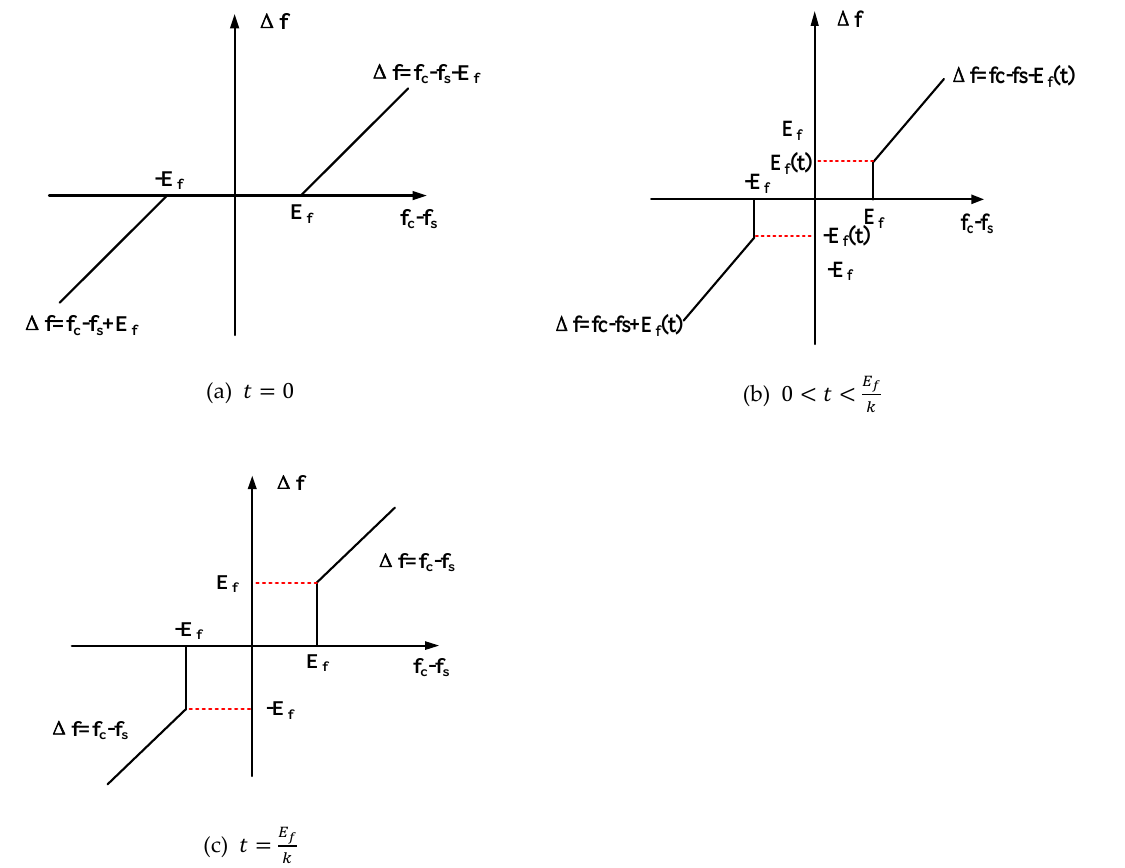
Figure 5. The improved frequency dead zone proposed in this paper.